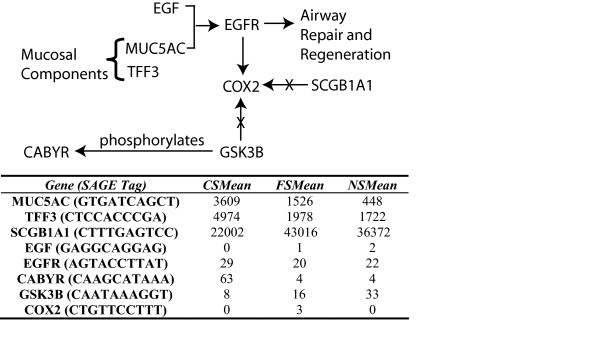
Expression trends of specific genes related to muco-ciliary function and airway restitution as compared with smoking status and lung cancer: TFF3, CABYR, and MUC5AC are over expressed in current smokers with lowered expression in both former and never smokers. Conversely, SCGB1A1 shows the opposite effect, with lowered expression in current smokers as compared to former and never smokers. MUC5AC and TFF3 are known to be components of mucus. EGFR levels are positively correlated with smoking status, with modestly higher levels in current smokers. MUC5AC and EGF have been shown to interact with EGFR in the process of airway restitution and SCGB1A1 has been shown to decrease levels of cyclooxygenase 2 (COX2) in cancer cells. Interestingly, within this process alone, we see reversible (TFF3, CABYR), partially reversible (MUC5AC) and completely irreversible (GSK3B) expression changes upon smoking cessation. Values refer to tag counts as tags-per-million (TPM).